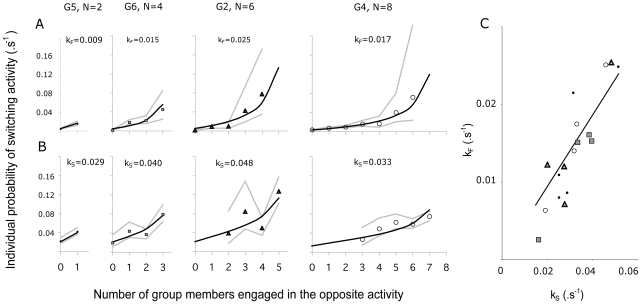
Individual probability of switching activity.Figures 1A and 1B represent the experimental (symbols: mean±CI95%) and theoretical (black lines; eq. (1)) individual probabilities of switching from foraging to scanning (TF→S) and from scanning to foraging activity (TS→F) as a function of the number of scanning or foraging conspecifics respectively. Figure 1A,B illustrate the results extracted from the analyses of 4 experimental groups composed of 2, 4, 6 and 8 individuals (G5, G6, G2 and G4, respectively). The adjusted values of the parameters kF and kS are indicated for each group (see eq. (1)). Fig. 1C shows the linear relationship between the kF and kS values for each tested group (r2 = 0.80, kF = (0.46)kS, F
1,17 = 69.6, P<0.001). Black points, grey squares, grey triangles and open circles represent the k values of tested groups composed of 2, 4, 6 and 8 sheep, respectively.